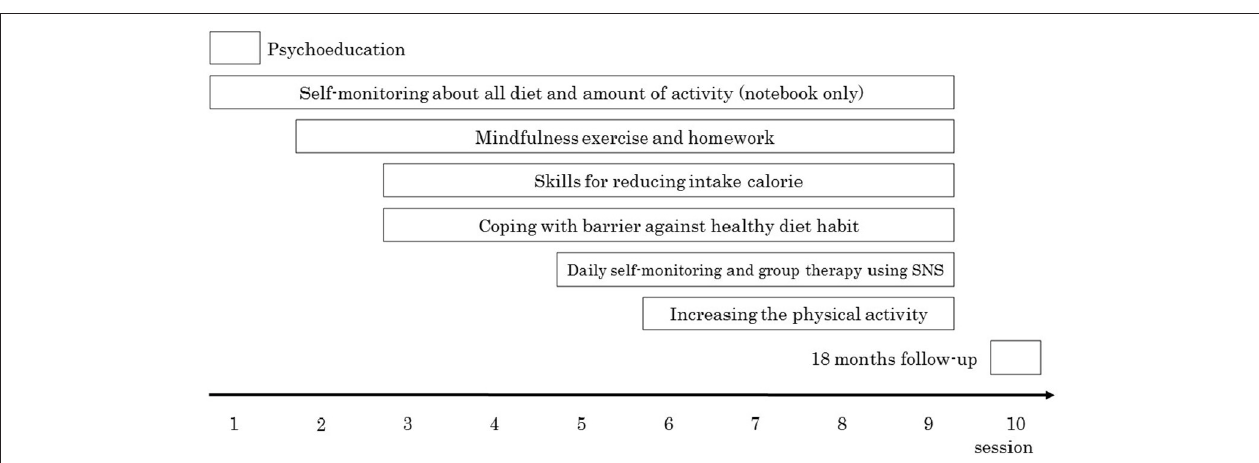
FIGURE 1 | Overview of the diet program in this study. Session 1–4 was only face to face session. From session 5, participants were required to upload daily food photographs to SNS page. Session, the distance from session 9–10 was months.